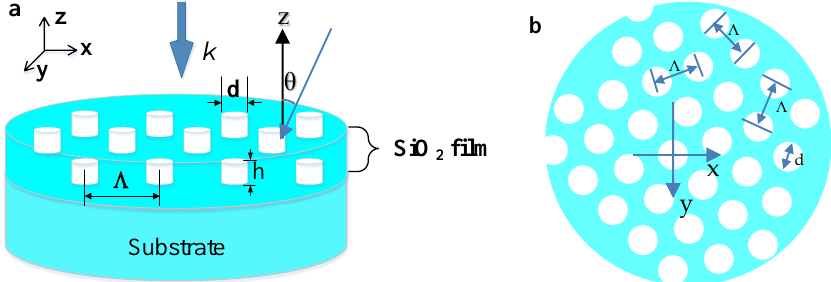
Figure 1. Scheme of the 2D grating structure: ( a ) side view, ( b ) top view.